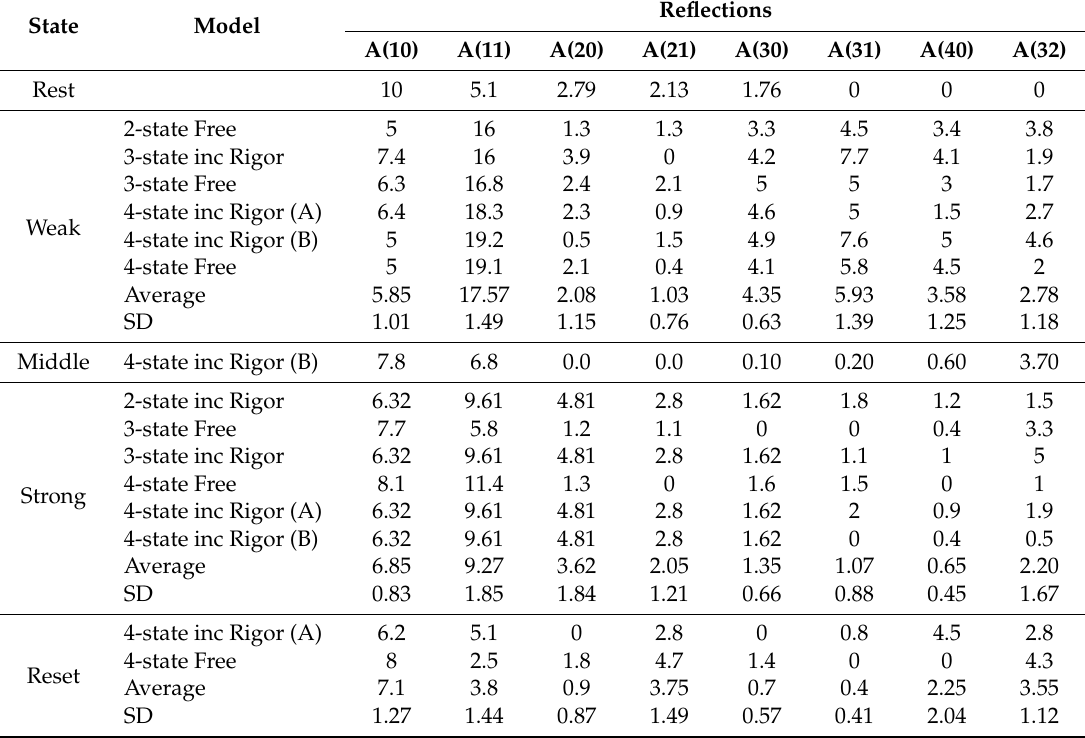
Table 5. Results on the best amplitudes from the equatorial modelling for the cycles shown in Figure 2b. Where “inc Rigor” has been used it indicates the strong state used was the rigor state. State